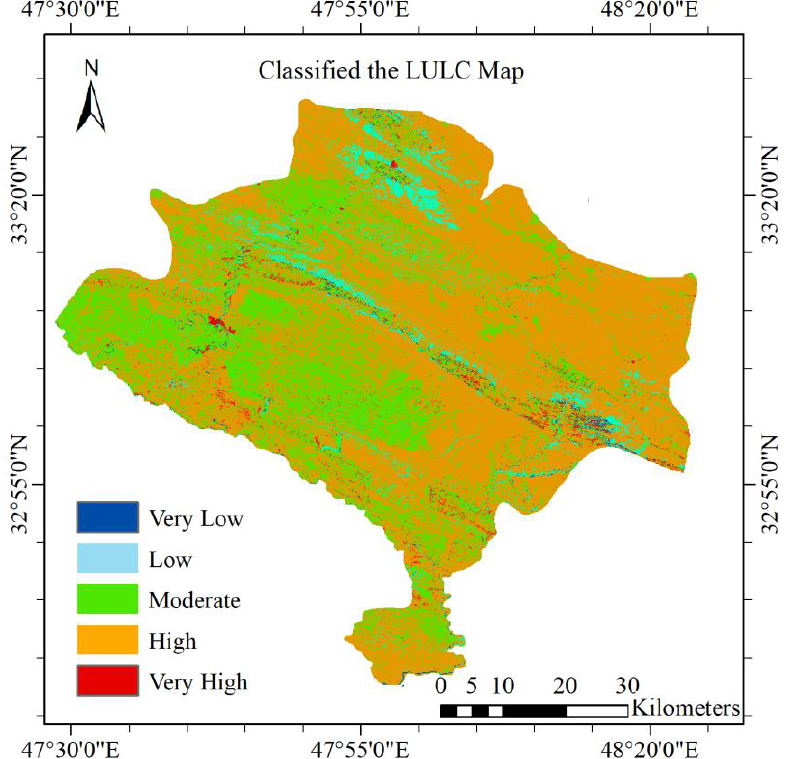
Figure 4. The reclassified LULC map of Pol-e Dokhtar based on the level of flood risk.